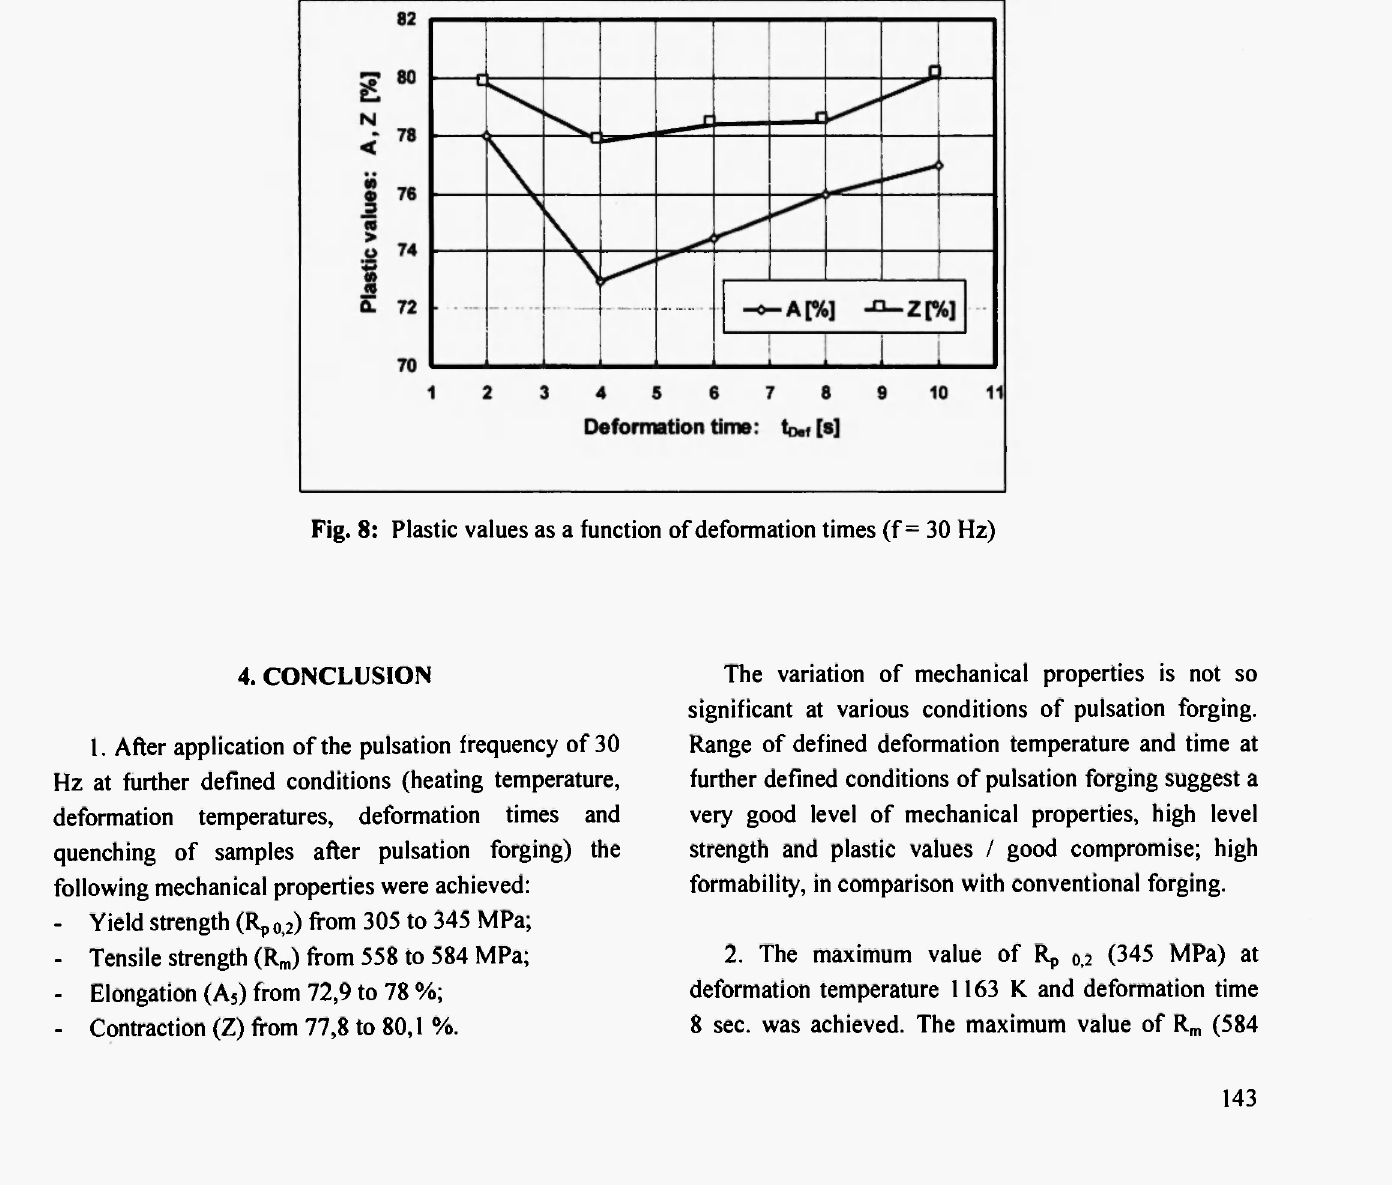
Fig. 7: Strength values as a function of deformation times (f = 30 Hz)